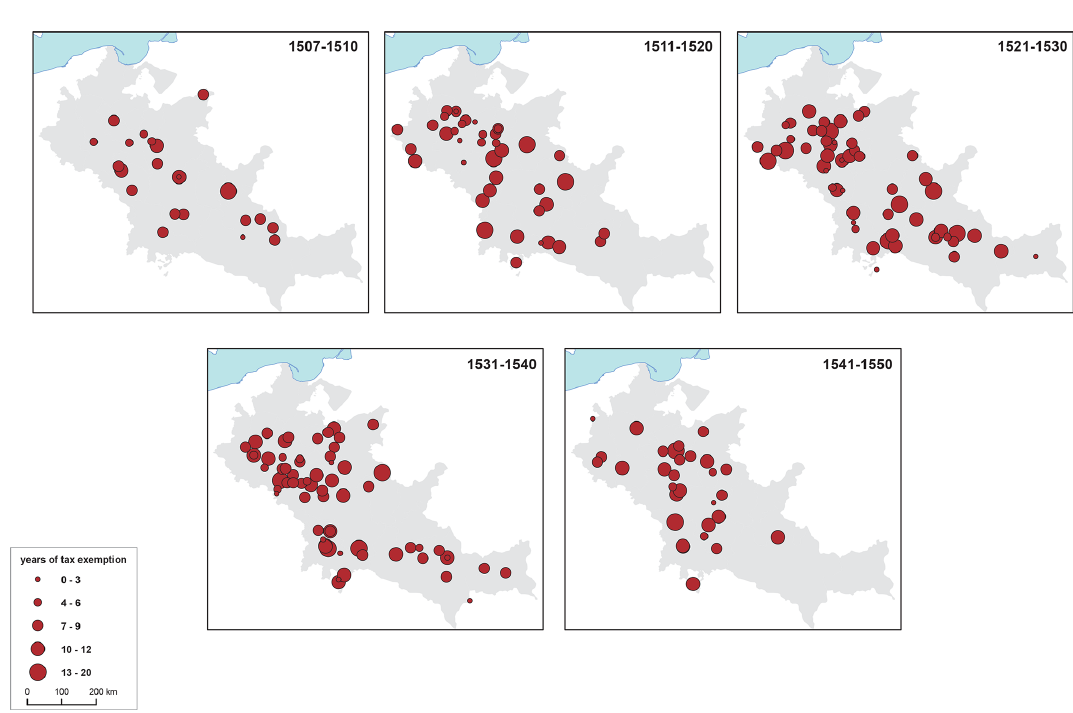
Figure 10. Spatial distribution of tax exemptions for cities and towns due to the fires. Source: Archival sources AS